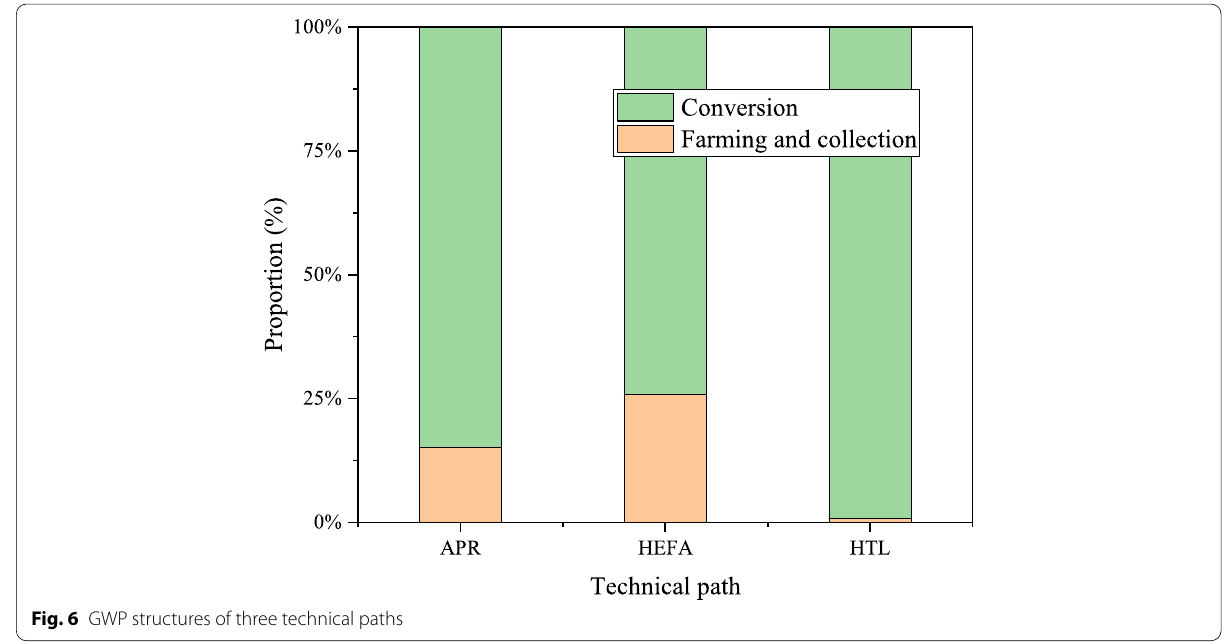
Fig. 6 GWP structures of three technical paths